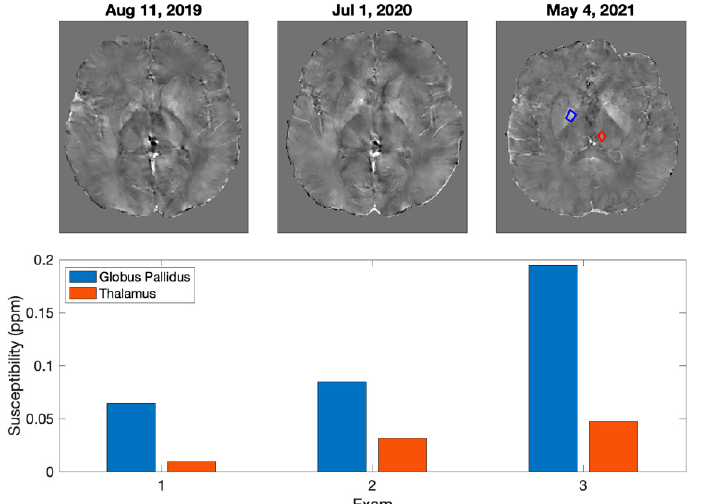
Figure 2. Example of one patient over time demonstrating increased iron accumulation following cranial radiation therapy. The longitudinal data over 632 days shows the utility of maintaining sequential routine QSM imaging and the ability to detect increases in iron over time. The patient (13 years old at diagnosis in 2019) underwent cranial radiation therapy involving whole ventricular zone coverage at 3600 cGy and a pineal boost at 1800 cGy concluding on 8/2019. Subsequent serial imaging demonstrates pathological increased accumulation of iron in the globus pallidus in an accelerated timeline as would be expected for this age.